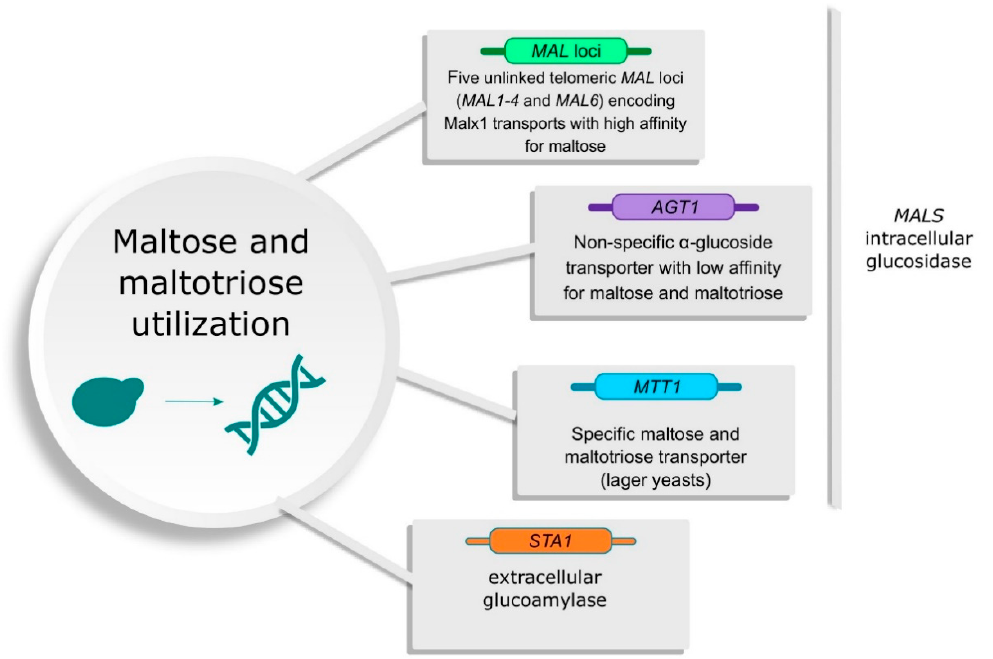
Figure 4. Maltose / maltotriose transporters in ale and lager yeasts. Main characteristics Figure 4. Maltose/maltotriose transporters in ale and lager yeasts. Main characteristics of alpha- glucoside transporters in ale and lager strains are reported, together with the extracellular Sta1 glucan 1,4-alpha-glucosidase, which could be involved in maltotriose assimilation in lager yeasts.